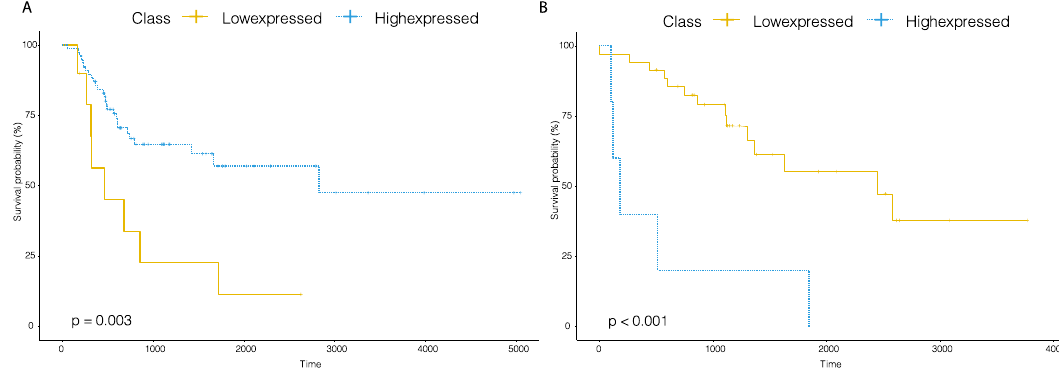
Figure 2. Kaplan–Meier curves of overall survival for patients treated with gemcitabine at low or high expressed classes stratified by miR-330 in the BLCA or SARC.